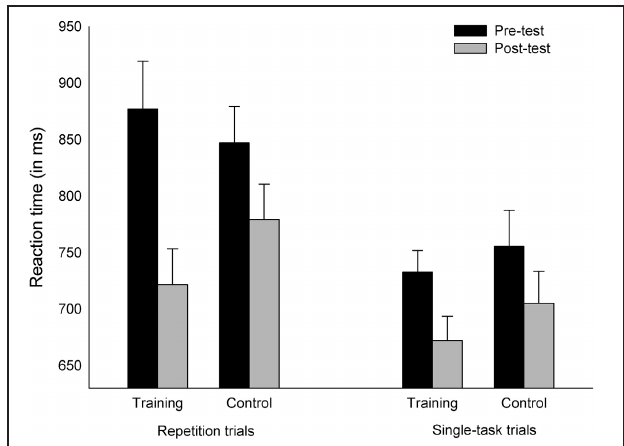
FIGURE 4 | Reaction times of the training and control groups in the repetition and single-task trials of the task switching experiment. Error bars indicate standard errors of the